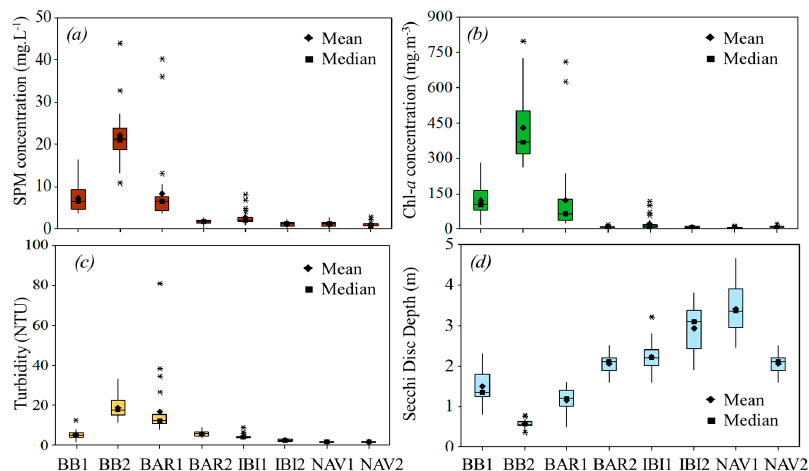
Figure 2. Boxplot of water quality parameters obtained in each field campaigns: ( a ) SPM concentration (mg · L − 1 ); ( b ) Chl- a concentrations (mg · m − 3 ); ( c ) Turbidity (NTU); ( d ) Secchi disk depth (Z SD , meters).